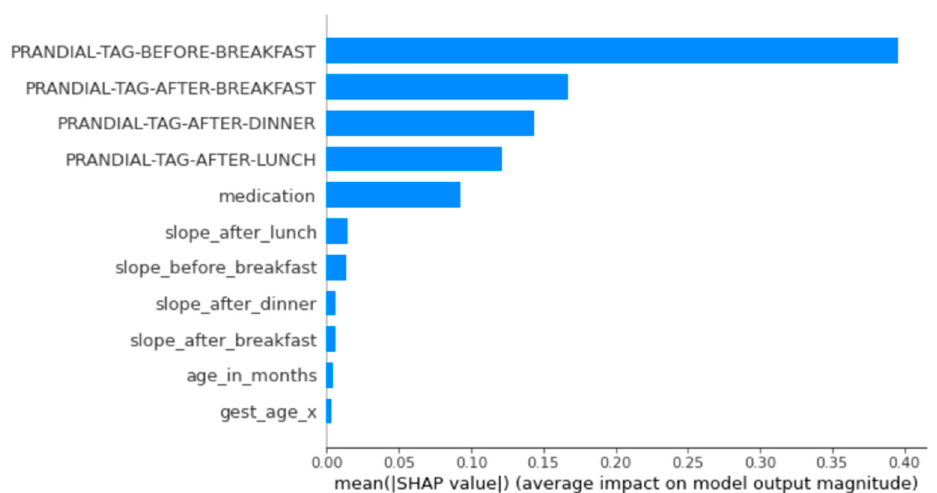
Figure A5. SHAP feature importance ranking for model trained on Tags and EHR features.